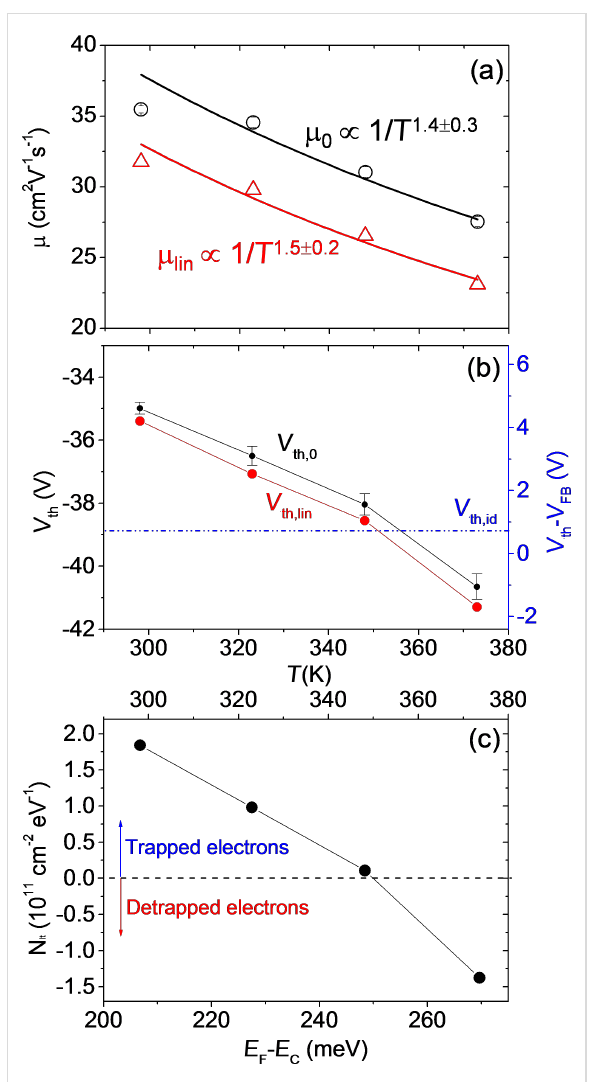
Figure 5: (a) Temperature dependence of the field effect mobility extracted from the linear region of the I D − V G characteristics without ( μ lin ) and with ( μ 0 ) the correction for the effect of the contact resis- tance R C . Experimental data have been fitted with a temperature de- pendence 1/ T α . (b) Temperature dependence of the threshold voltage evaluated without ( V th,lin ) and with ( V th,0 ) the correction for the effect of the contact resistance R C . (c) Density of trapped/detrapped electrons at MoS 2 /SiO 2, as a function of T (upper scale) and the corresponding position of the Fermi level with respect to the conduction band ( E F − E C